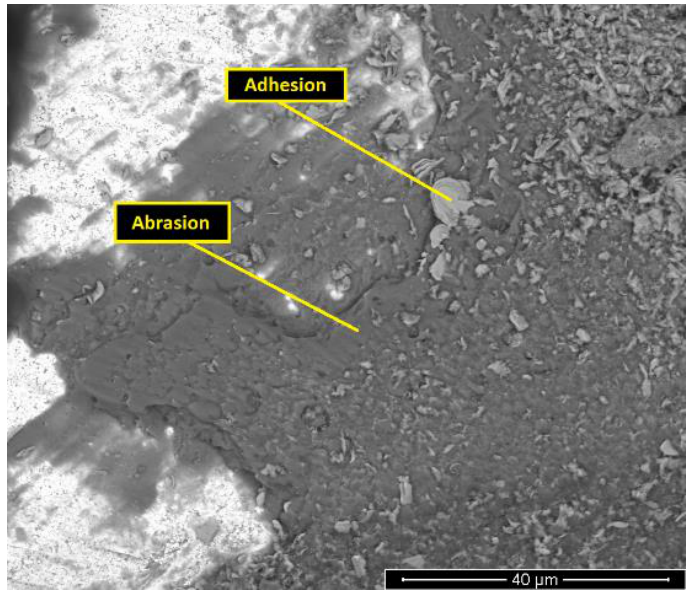
Figure 15. Material adhesion and abrasive wear detected on a T3 tool’s rake face, tested at 125% feed rate.